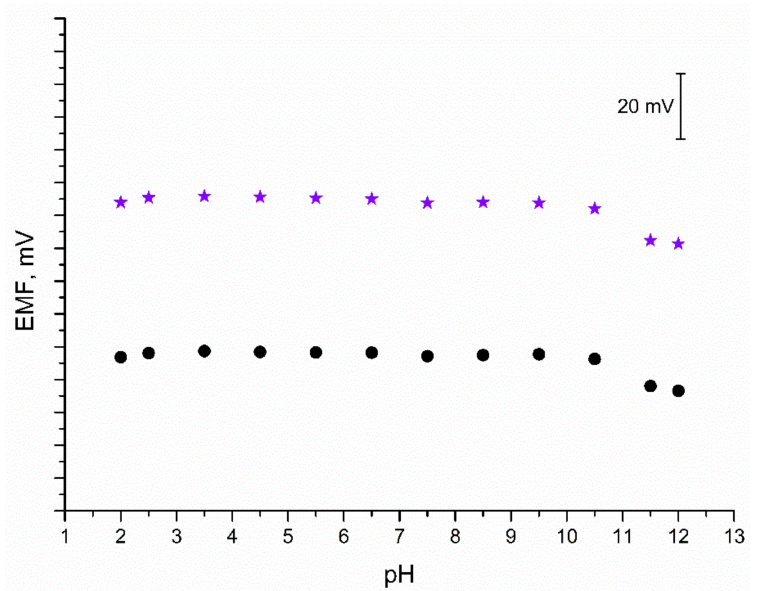
Figure 7. pH test: stability of potentiometric response of GC/IrO 2 · 2H 2 O/K + -ISM ( (cid:70) ) and GC/K + - ISM electrode ( • ) recorded in 0.01 M KCl solutions of varying pH value